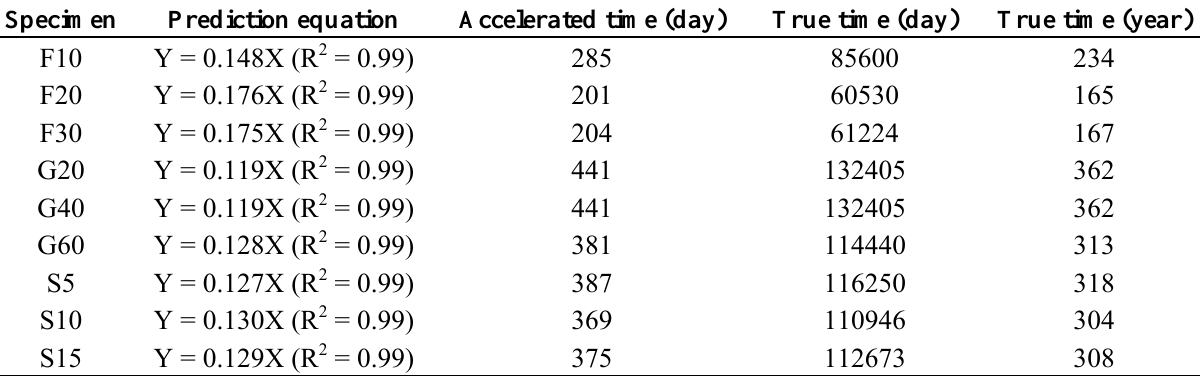
Table 7. Predicted leaching time for cement-based materials with mineral